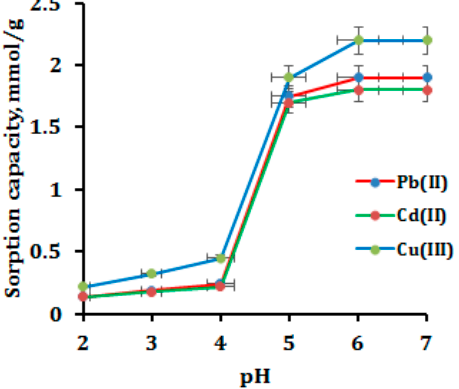
Figure 4. Effect of sample pH on the adsorption of metal ions.